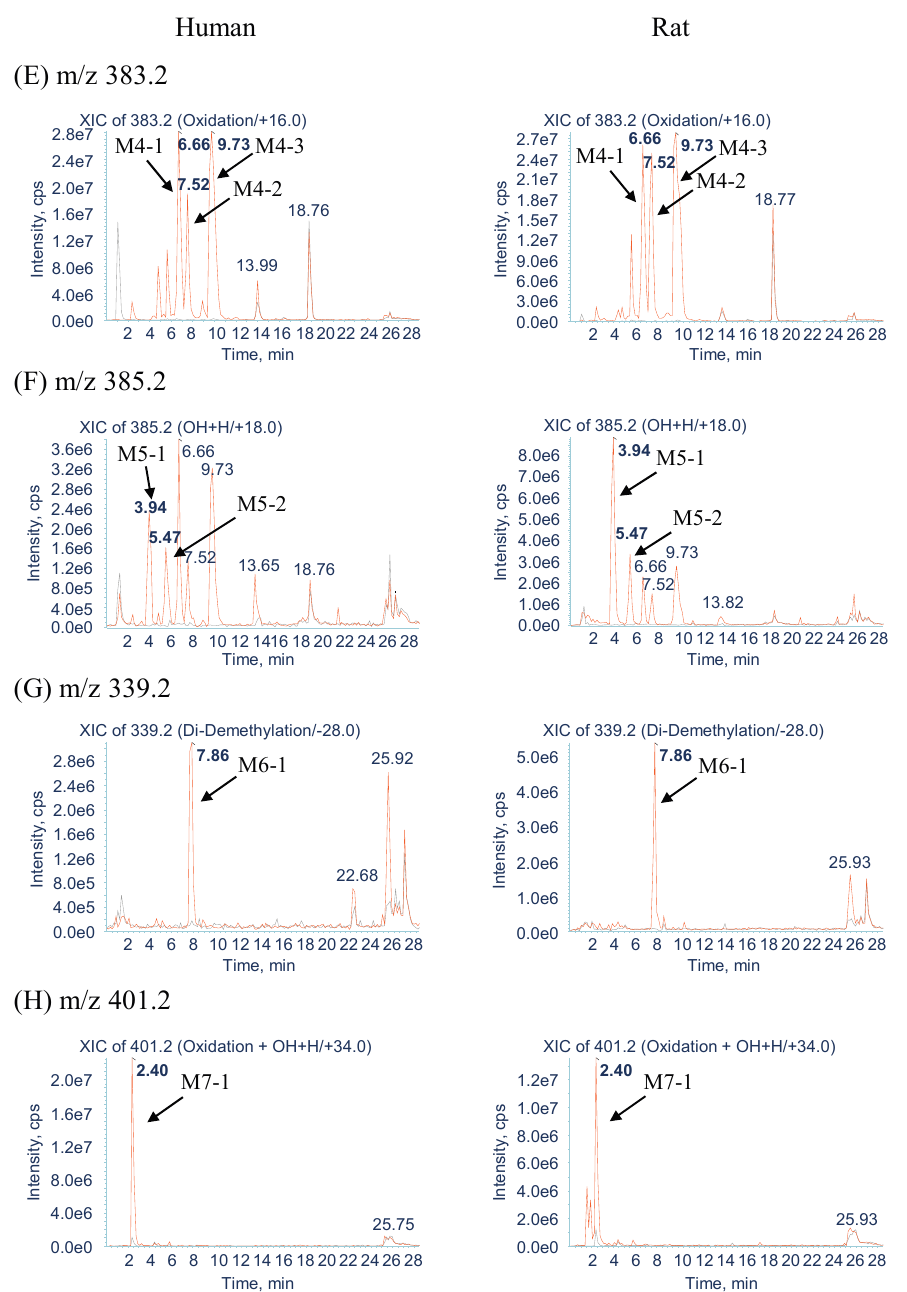
Figure 2. Full-scan total-ion and extracted-ion chromatograms of GM metabolites in rat and human microsomes. ( A ) Full-scan total-ion chromatogram ( m / z